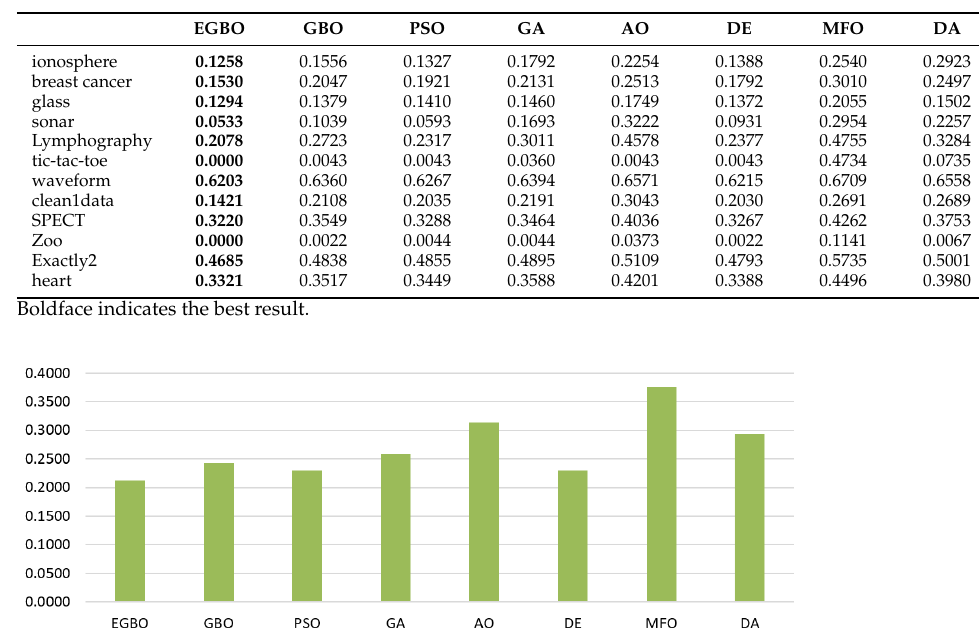
Table 8. Results of the fitness function values.